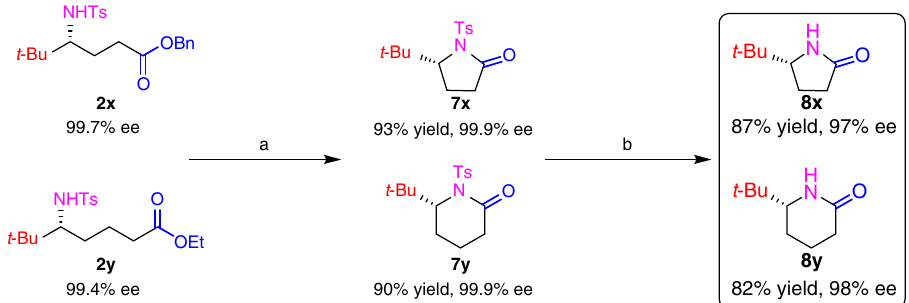
Fig. 3 Functionalized product derivatization. Reagents and conditions are as follows. a 2x , y (0.5 mmol), Me 3 Al (0.6 mmol), toluene (15 mL), 80 °C, overnight. b 7x, y (0.5 mmol), naphthalene (5.0 mmol), sodium (5.0 mmol), DME (30 mL), – 70 °C, 1